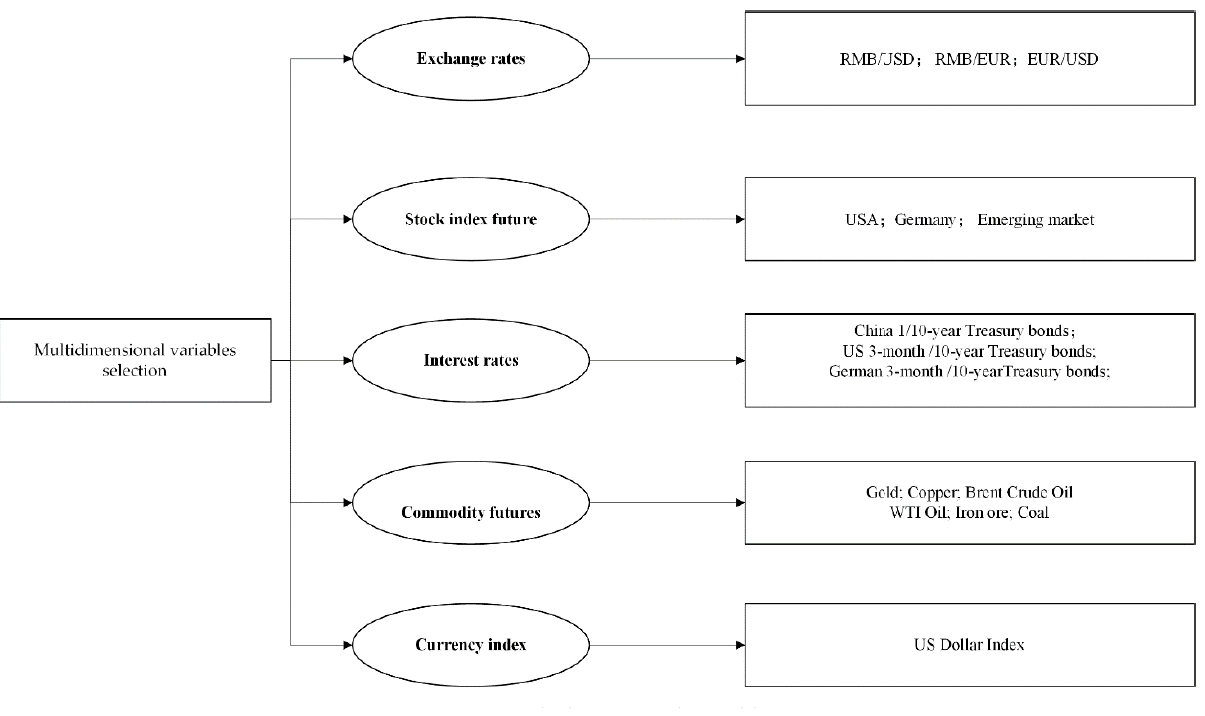
Figure 4 . Multidimensional variables. Figure 4. Multidimensional variables.